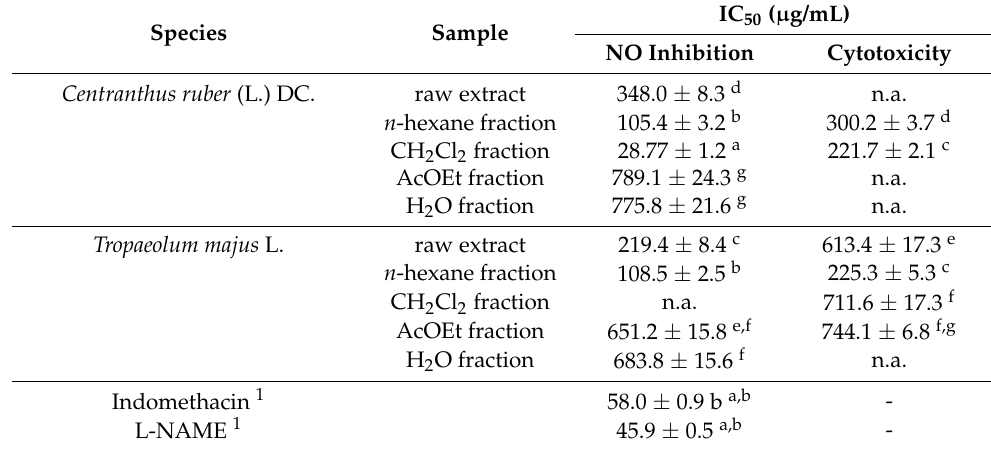
IC 50 ( µ g/mL) NO Inhibition Cytotoxicity